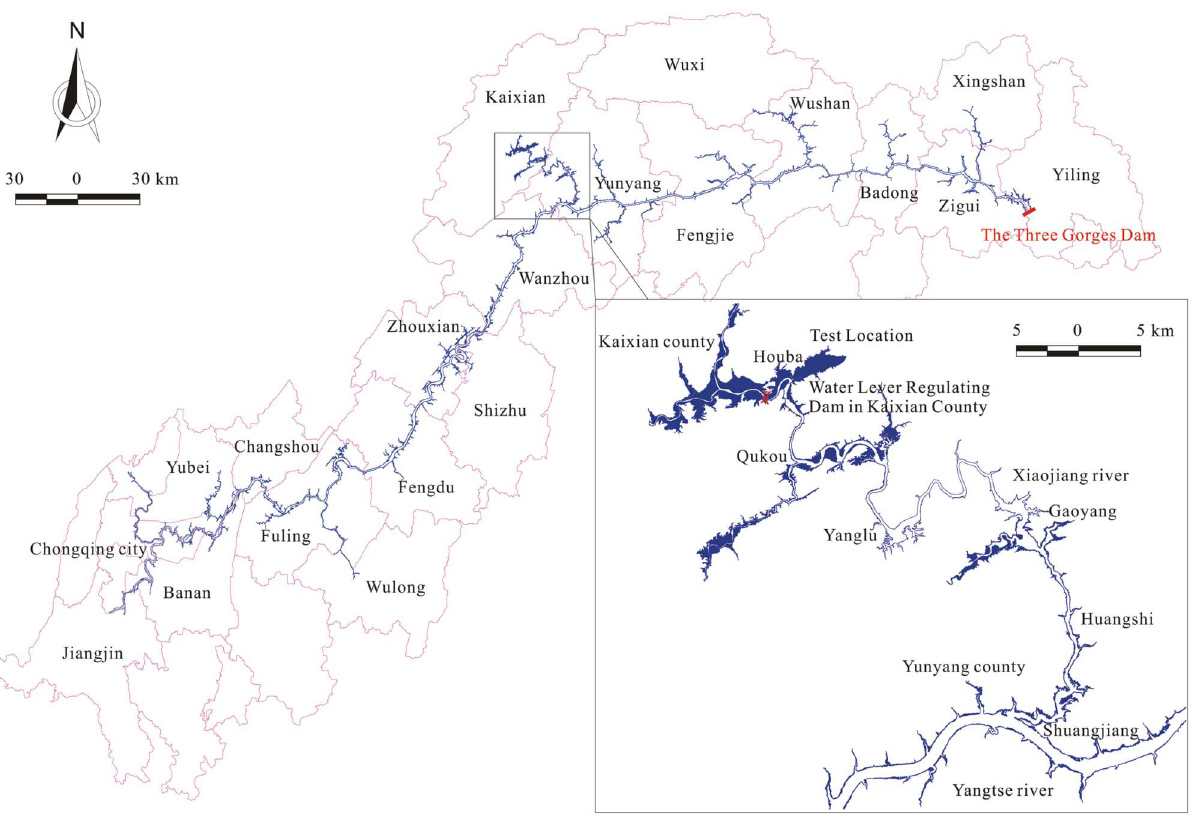
Fig 1. Location of the experimental